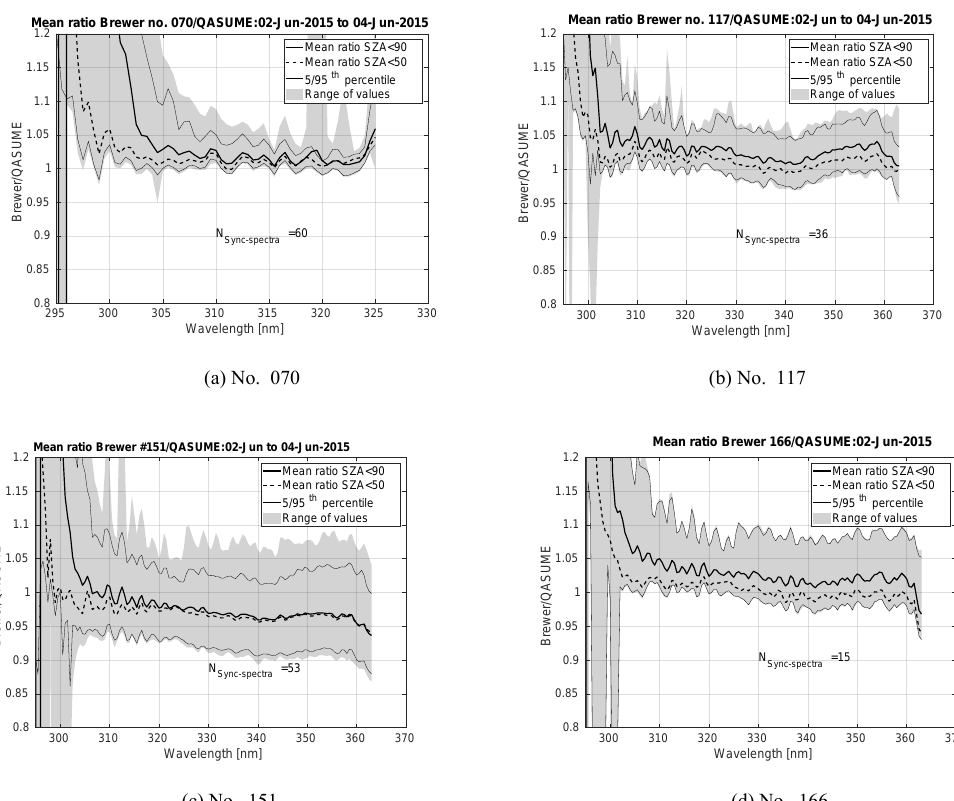
Figure 7. Mean ratio and range of measurements between Brewers (a) no. 070, (b) no. 117, (c) no. 151 and (d) no. 166 and QASUME irradiances for measurements done at SZA < 90 ◦ and SZA < 50 ◦ in the comparison campaign in Huelva during 2–4 June 2015. The 5th and 95th percentile and the range of the values, and the number of QASUME synchronised spectra (N_sync_spectra) are shown. The data was cosine error